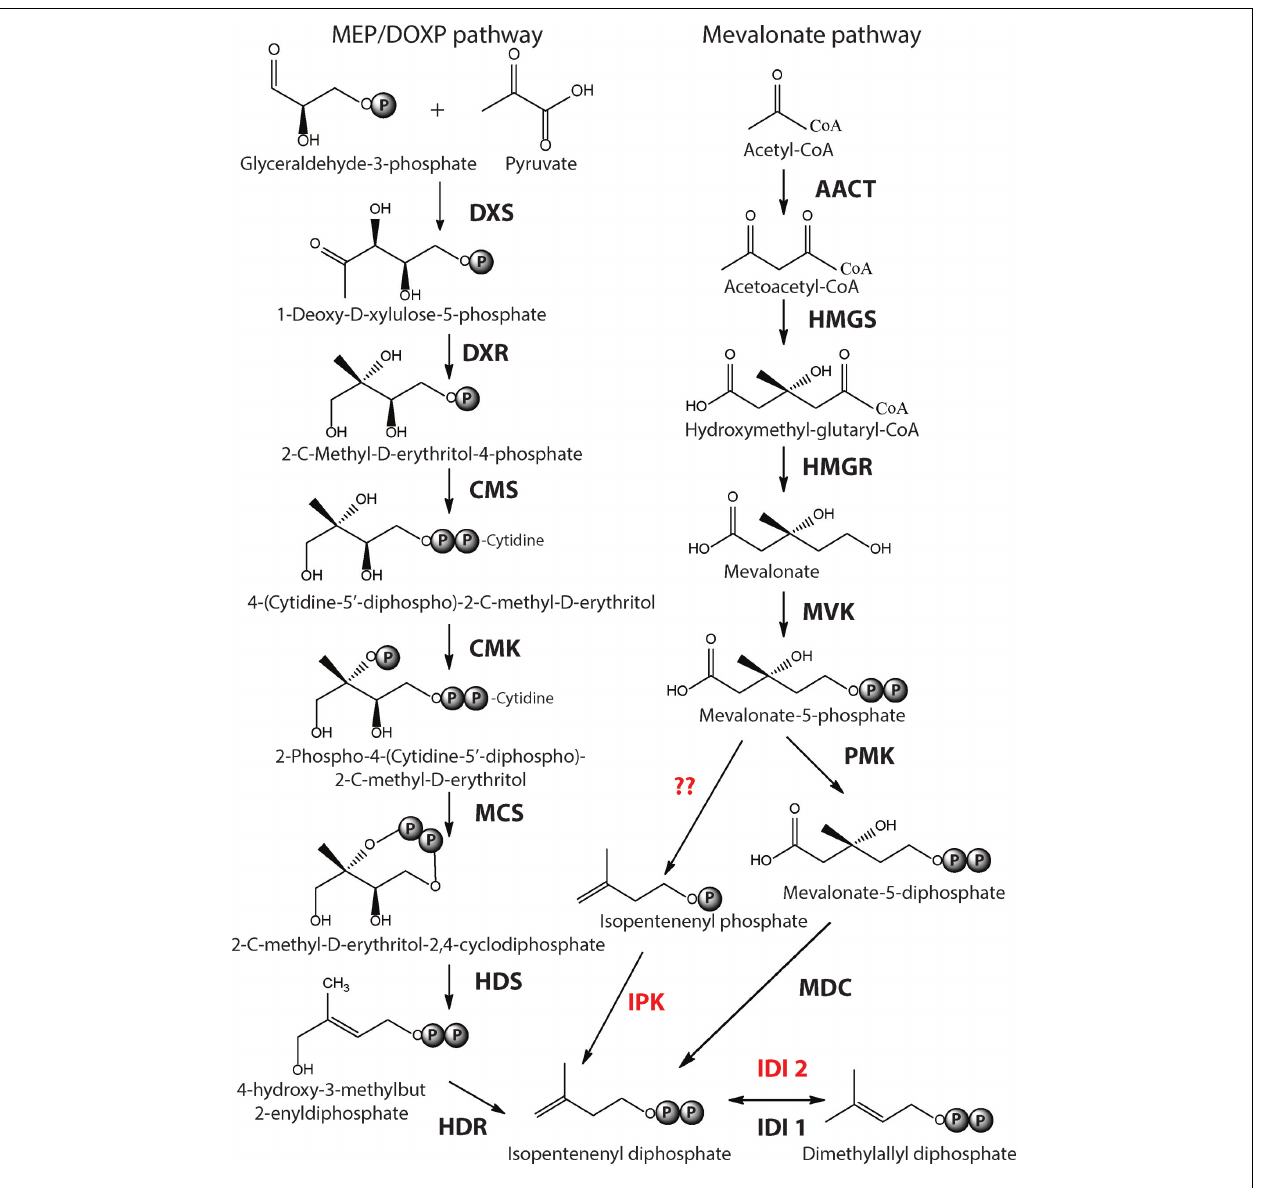
FIGURE 1 | Biosynthesis of Isoprenoid building blocks. The three pathways leading to the synthesis of IPP and DMAPP – MEP/DOXP pathway, Mevalonate and the alternate mevalonate pathway (in red), which is prevalent in archaea are shown. Mevalonate and the alternate mevalonate pathways share four of their seven enzymatic steps.The enzyme acronyms are written in bold. DXS, 1-Deoxy-d-xylulose 5-phosphate synthase; DXR, 1-Deoxy-d-xylulose 5-phosphate reductase; CMS, 2-C-methyl-d-erythriol 4-phosphate cytidyltransferase; CMK, 4-diphosphocytidyl-2-C-methyl-